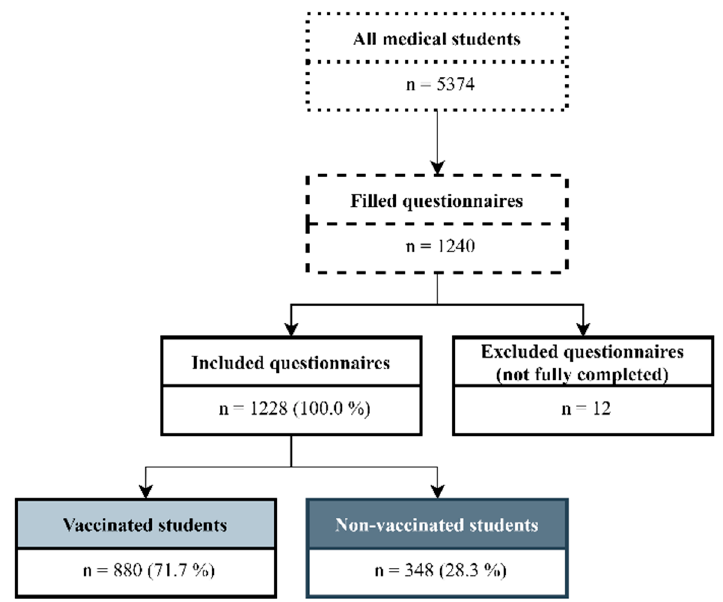
Figure 1. Study flow chart.